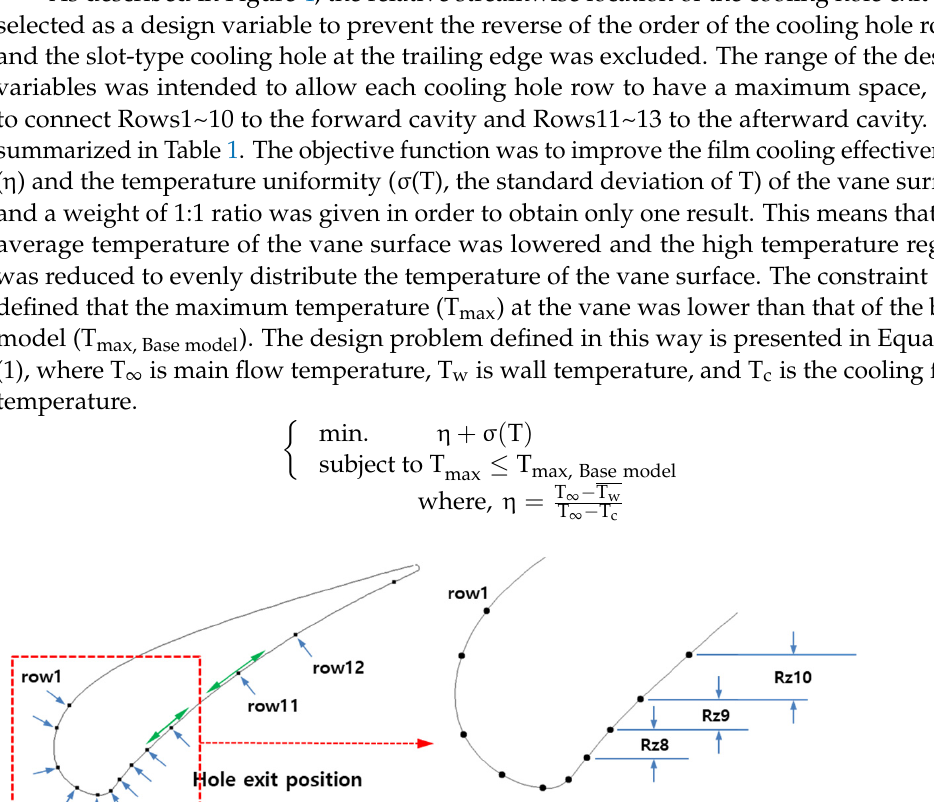
Figure 4. Definition of design variables (reprinted with permission from [16]; copyright 2021 Korean Society for Fluid Machinery). Table 1. Range of design variables (reprinted with permission from [16]; copyright 2021 Korean Society for Fluid Machinery).